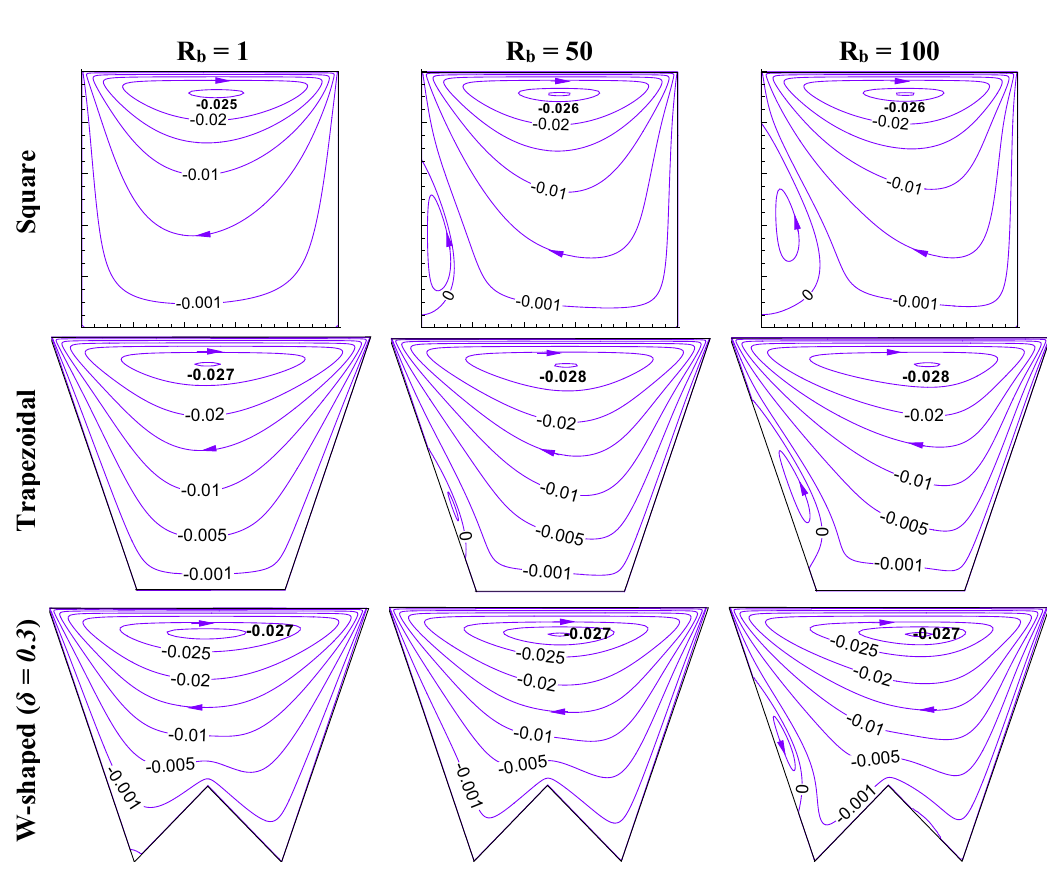
Figure 2. Streamline contours ( ψ ) for different geometric cavity at Le = Pe = 1, Gr = 10 4 , Da = 10 –3 , Ha = 30 for square, trapezoidal and W-shaped